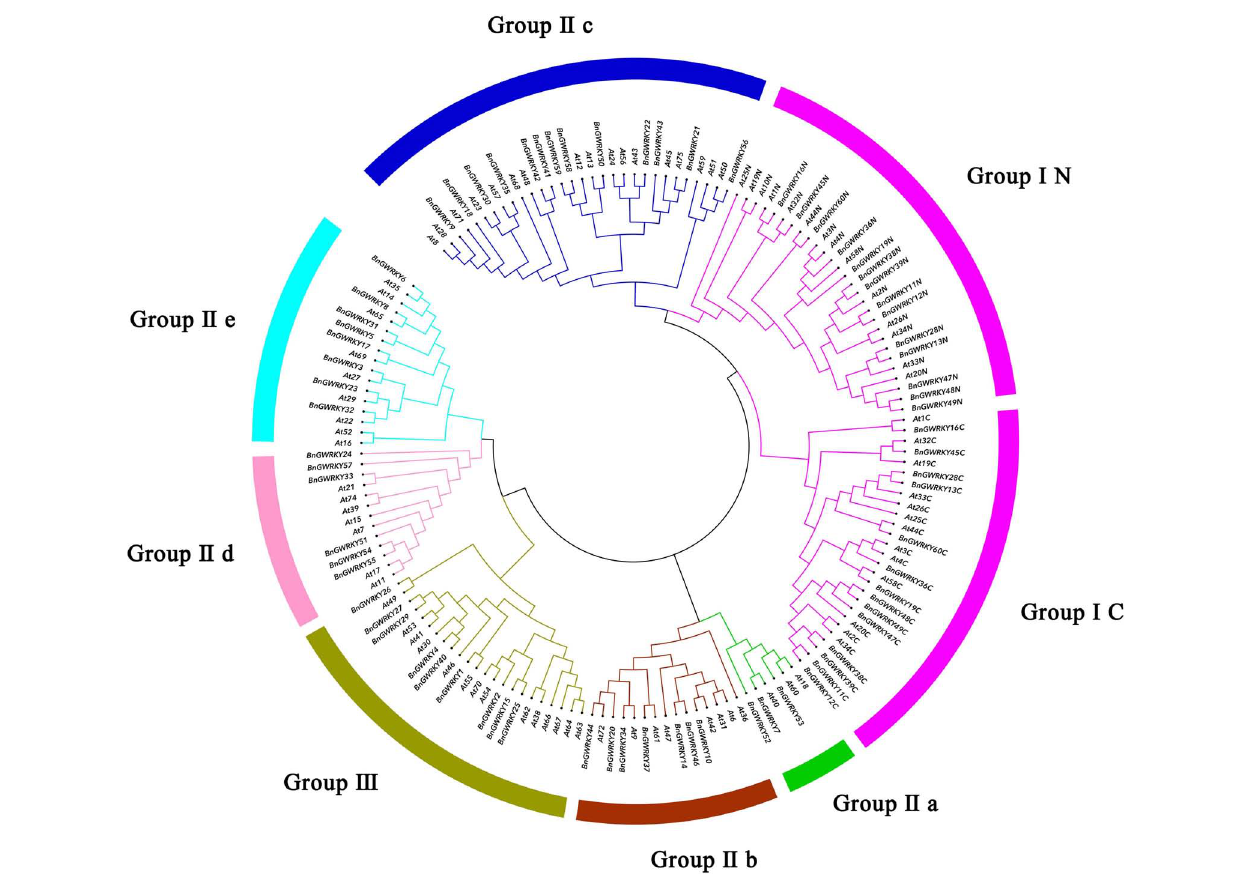
FIGURE 2 | Phylogenetic tree (Guo et al., 2019) representing relationships among WRKY domains of Boehmeria nivea and Arabidopsis thaliana using MEGA-X with 1,000 bootstrap replicates. The arcs with different color represent seven subgroups of WRKY proteins. Group I proteins with the suffix “N” or “C” indicates the N-terminal or the C-terminal WRKY